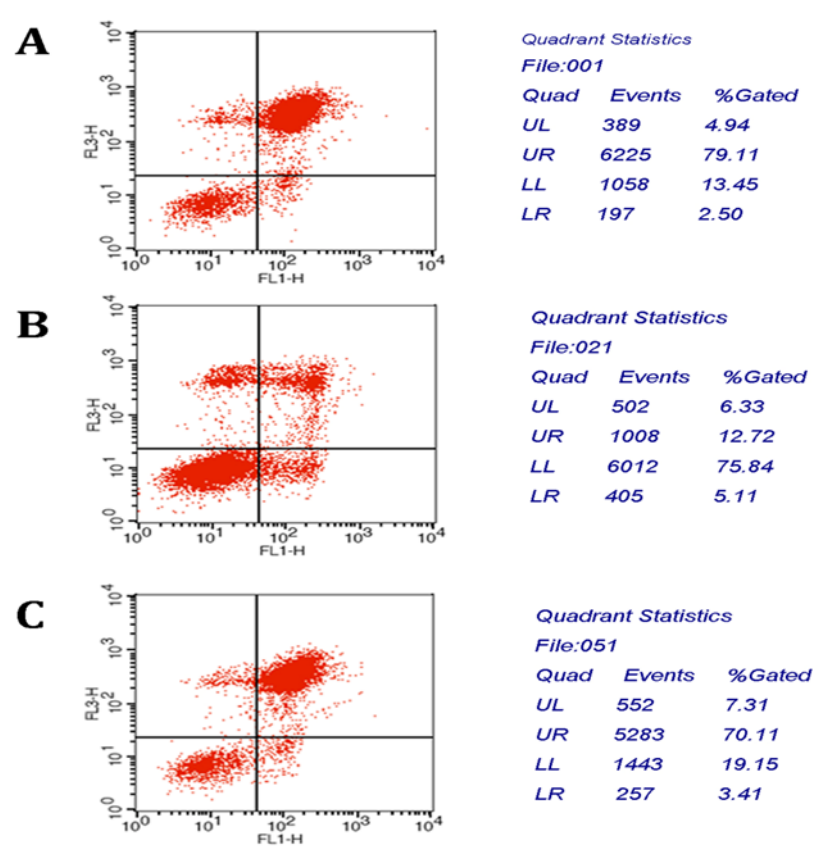
Figure 9. Apoptosis of cells were determined by flow cytometry analysis. Compared with the cells without the treatment of CIAPIN1 siRNA, the apoptosis rate significantly increased after RNAi. ( A ): MCF7; ( B ): MCF7/ADM before RNAi; ( C ): MCF7/ADM after RNAi.